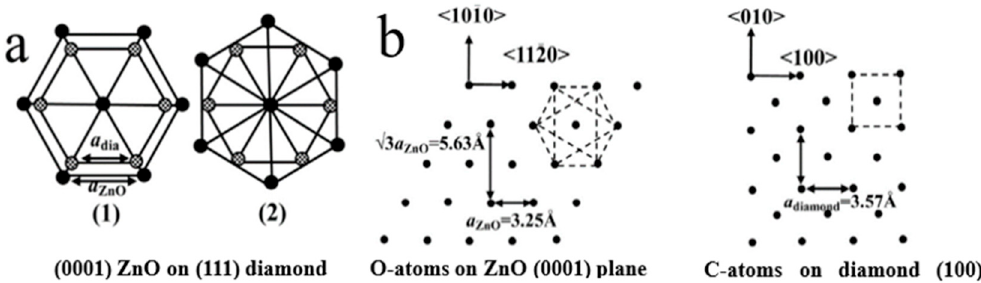
Figure 9. Schematic illustration atomic arrangement of ( a ) ZnO (0001) and diamond (111) planes and ( b ) ZnO (0001) facet and diamond (100) plane epitaxial relationship [23].